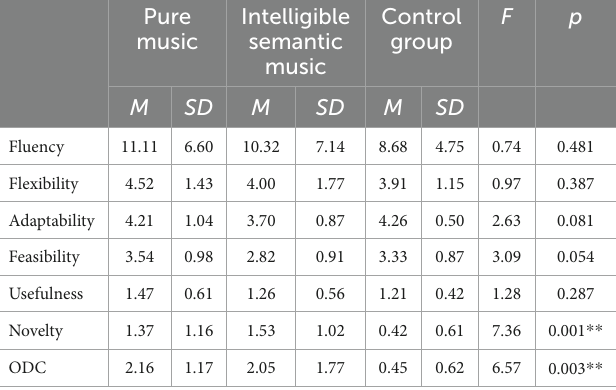
TABLE 2 Means and standard deviations of the assessment of creativity